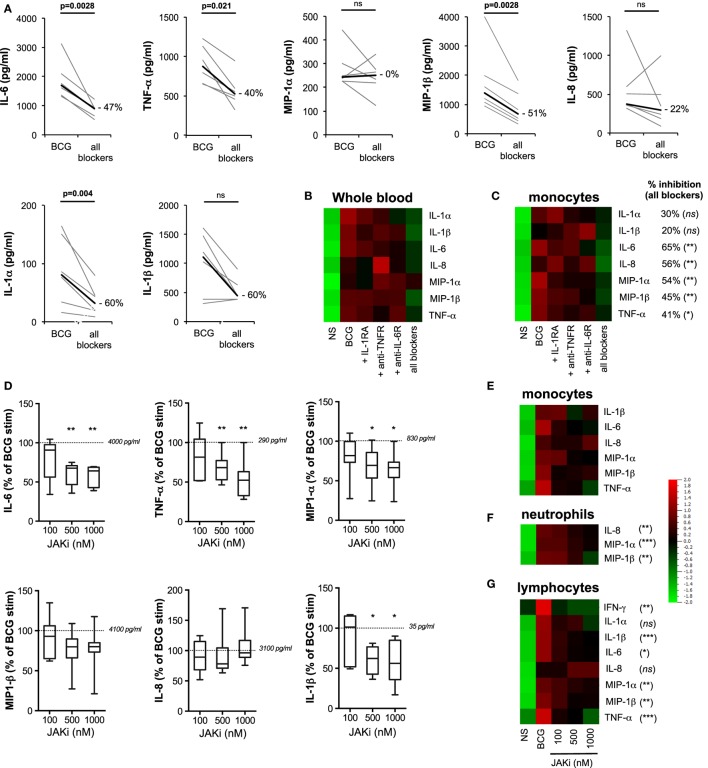
Feed-forward action of induced cytokines amplifies innate response to bacillus Calmette–Guérin (BCG). (A–C) The concentrations of cytokines were measured for whole blood and purified monocytes from healthy donors stimulated for 5 h with BCG in the presence of recombinant IL-1RA, anti-TNFR, and anti-IL-6R antibodies (referred to as “all blockers,” n = 6). (A) Detailed results from whole blood were represented as pair analyses, each line indicates a donor and the thick black line represents median values. Heat maps’ representation of the median concentration for the listed cytokines for whole blood [(B), n = 6] and purified monocytes [(C), n = 4–8], stimulated with BCG in the presence of the indicated blocking receptor reagent(s), BCG in the presence of isotype control antibodies, or buffer control [non-stimulated (NS)]. Percent inhibition between “all blockers” condition and BCG condition is indicated for each cytokine. (D–G) Purified monocytes (n = 7), neutrophils (n = 9), or lymphocytes (n = 7) were stimulated by BCG in the presence of increasing doses of the JAK1/2 inhibitor Ruxolitinib, and the quantification of cytokines were measured using Luminex assay. (D) Box-whisker plots indicate the percentage inhibition as compared to BCG stimulation for purified monocytes (normalized to 100% across experiments). The dotted lines indicate the median values for BCG stimulation for each cytokine. (E) Heat maps represent the median concentration determined for monocytes, (F) neutrophils, and (G) lymphocytes. p Values were determined by the paired Student’s t-test and false discovery rate corrected for multiple analyte testing. *q ≤ 0.05; **q ≤ 0.01; ***q ≤ 0.001 as compared to BCG + isotype control or DMSO control.